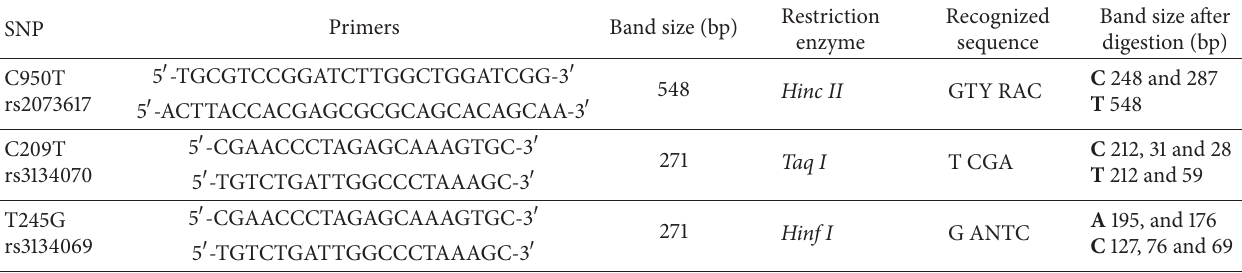
Table 1: Genotyping strategies for TNFRSF11B polymorphism variants